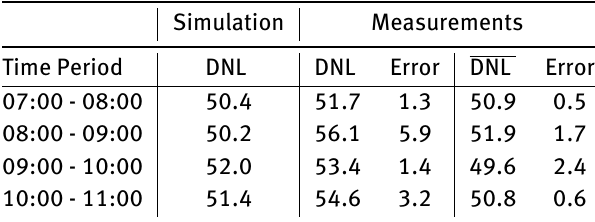
Table 2: DNL comparison between full time recordings (columns 2 and 3) and selected events (columns 4 and